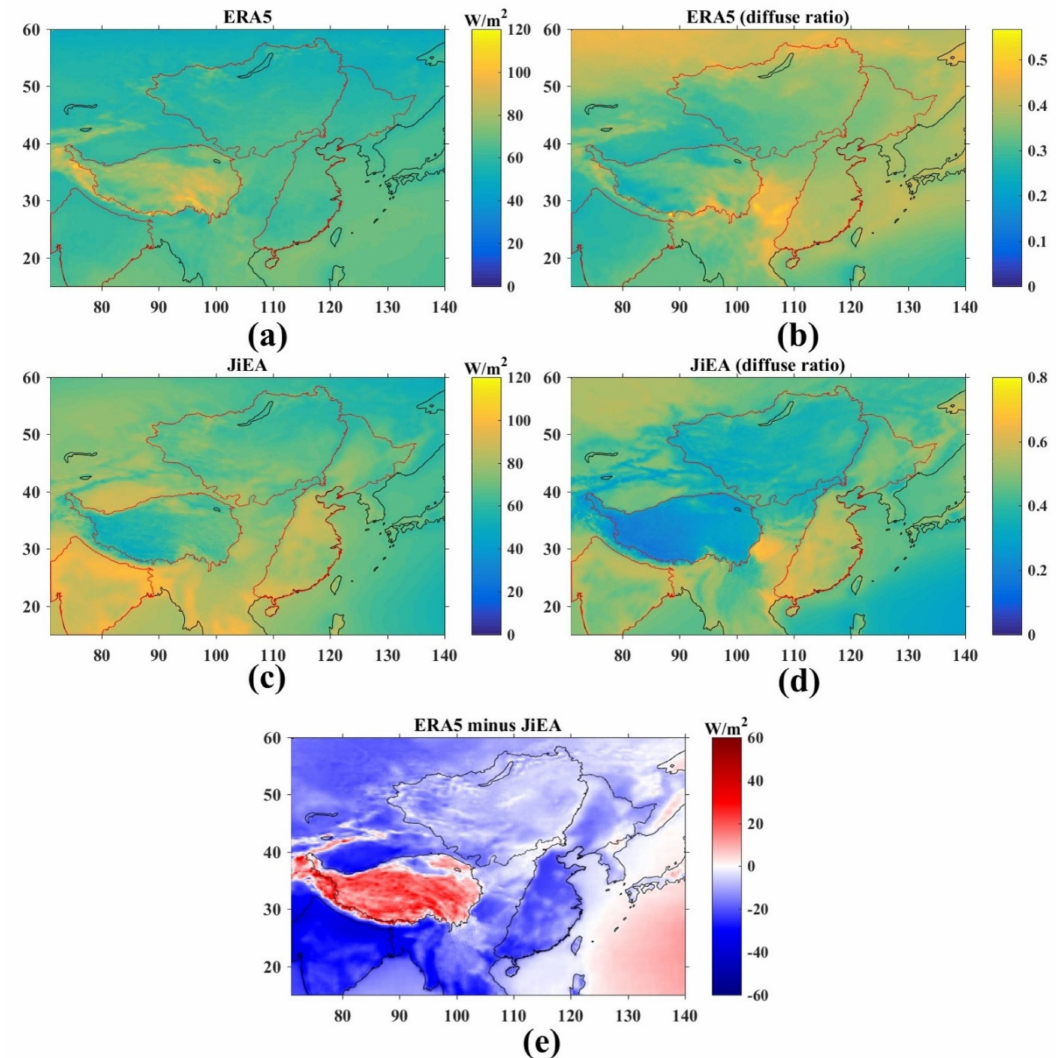
Figure 7. Spatial distribution of R dif over East Asia: ( a , b ) annual average (2007–2014) and its fraction in relation to R s estimated by ERA5 datasets; ( c , d ) analogous to (a,b) after upscaling estimates of JiEA to 0.25 ◦ ; ( e ) the di ff erence between ERA5 and JiEA (ERA5 minus JiEA). Both BESS and SolarGIS confirm that ERA5 seriously underestimates R dif at low latitudes. The large amount of R dif is the combined result of high-density downward radiation and strong scattering e ff ects of water vapor. An additional contribution comes from aerosols for the southern Himalayas and from clouds (high CF and middle COT) for South China. The amount of R dif from JiEA is approximately equal to that from SolarGIS, but their di ff use ratios are discrepant, implying an underestimation of R s by JiEA. In Sichuan Basin and the middle and lower reaches of the Yangtze River, COT and water vapor account for a large amount of R dif . In North China, AOD occupies the dominant role in a ff ecting the estimate of R dif . Due to the low R s caused by high CF, the ratio of R dif to R s can reach around 0.7 in these regions (Figure 7d). As indicated by site-level evaluation (Beijing, Chengdu, Wuhan and Shanghai in Figure S4), the underestimation of ERA5 seems certain. Another area of concern is the Taklimakan Desert, where both CF and COT are low but aerosols and atmospheric water vapor are high. Therefore, we believe that the high amount (~90 W / m 2 ) and middle ratio (~0.5) of R dif is possible. In addition, the regional average is very close to the measured values at Kashi station (Figure S4). Based on the above analysis, we are confident in the reliability of JiEA and believe that underestimation indeed occurs for ERA5 in related regions. Global simulations of